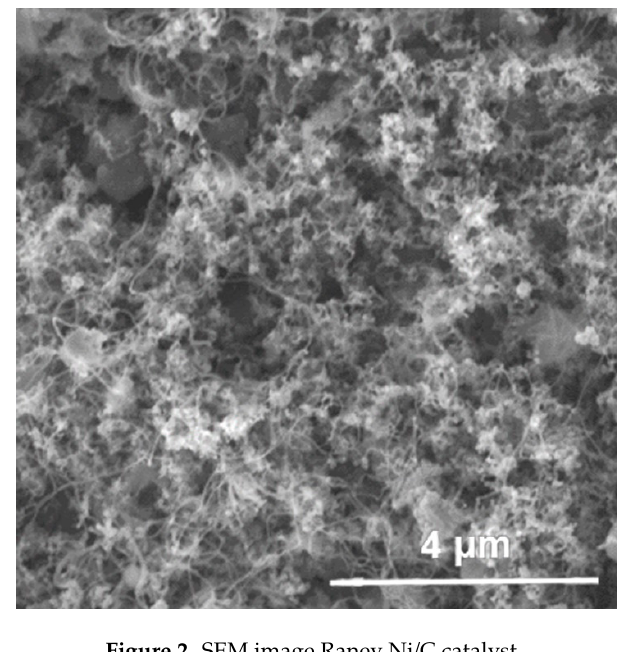
Figure 2. SEM image Raney Ni/C catalyst.